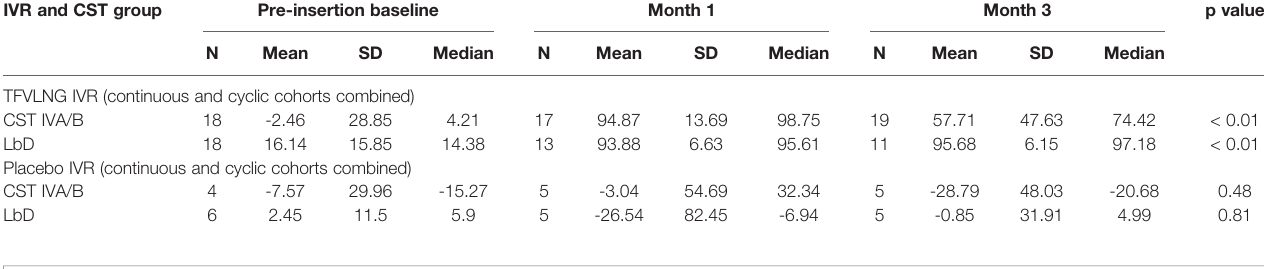
Placebo IVR (continuous and cyclic cohorts combined) CST IVA/B